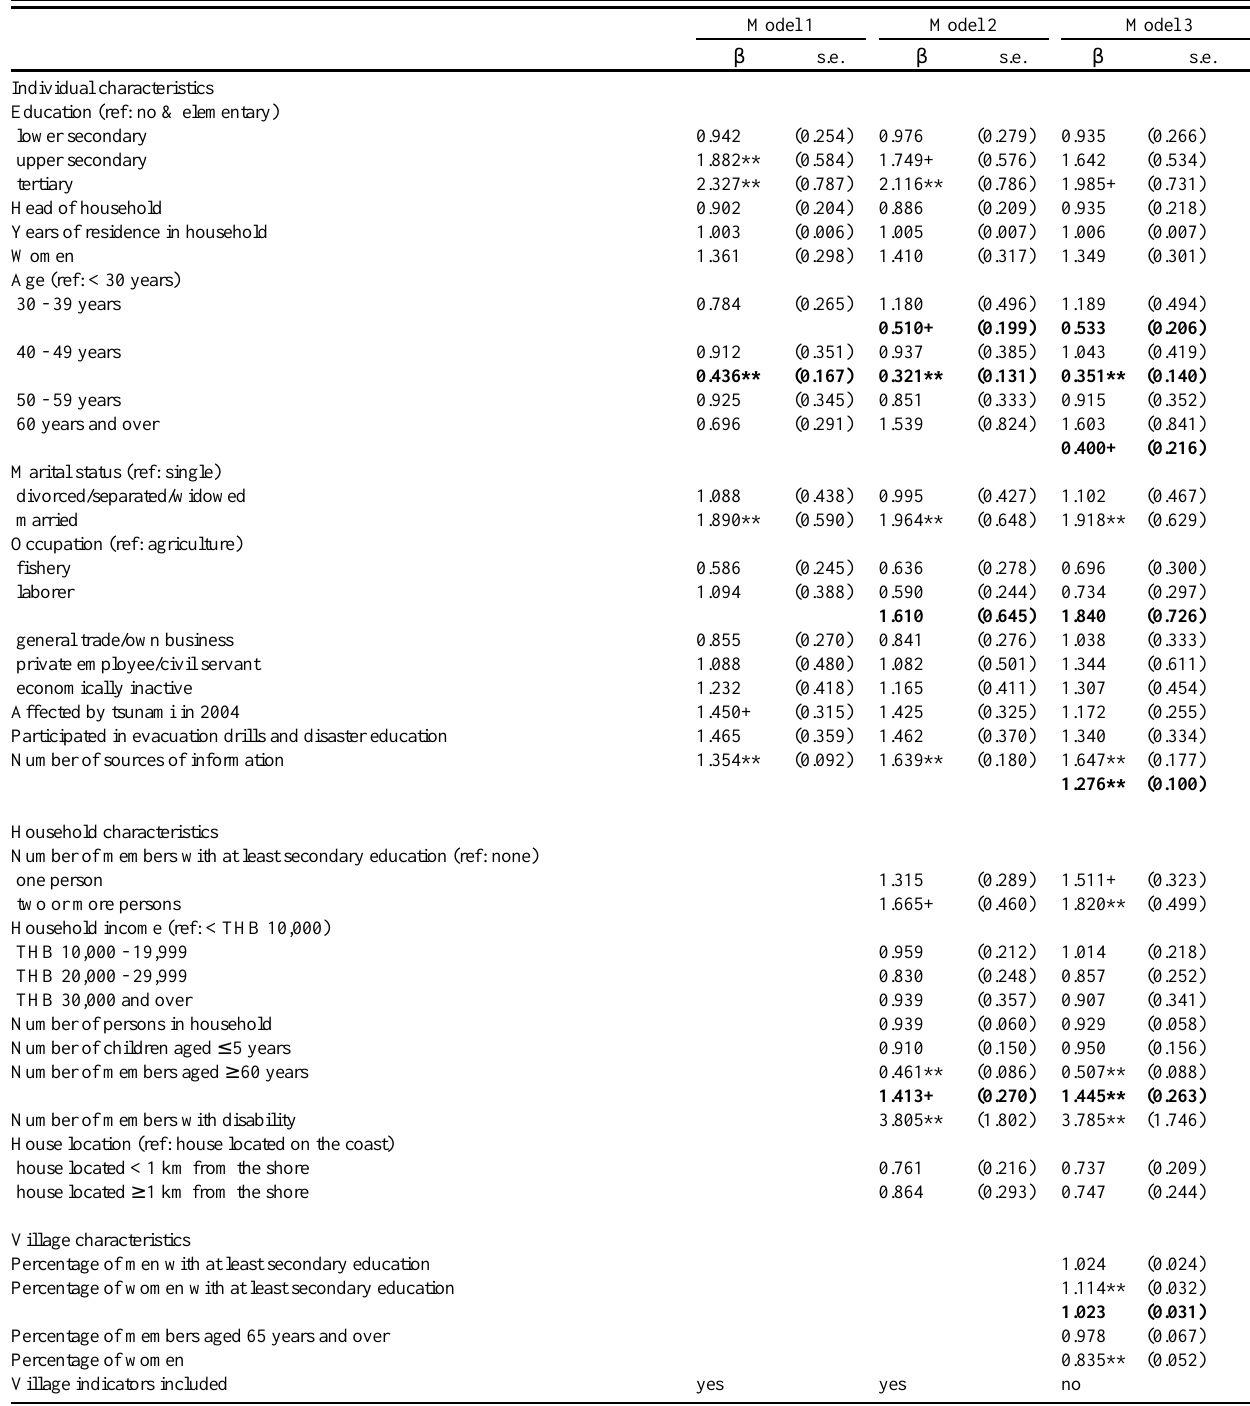
Table 2 . Odds ratio estimated from partial proportion odds ordered logit models predicting disaster preparedness with village indicators and